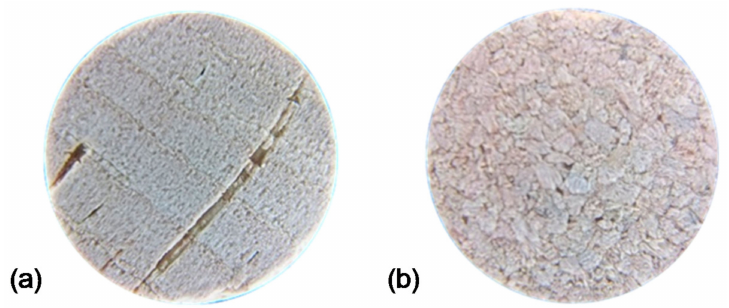
Figure 6. Cork types: ( a ) natural; ( b )